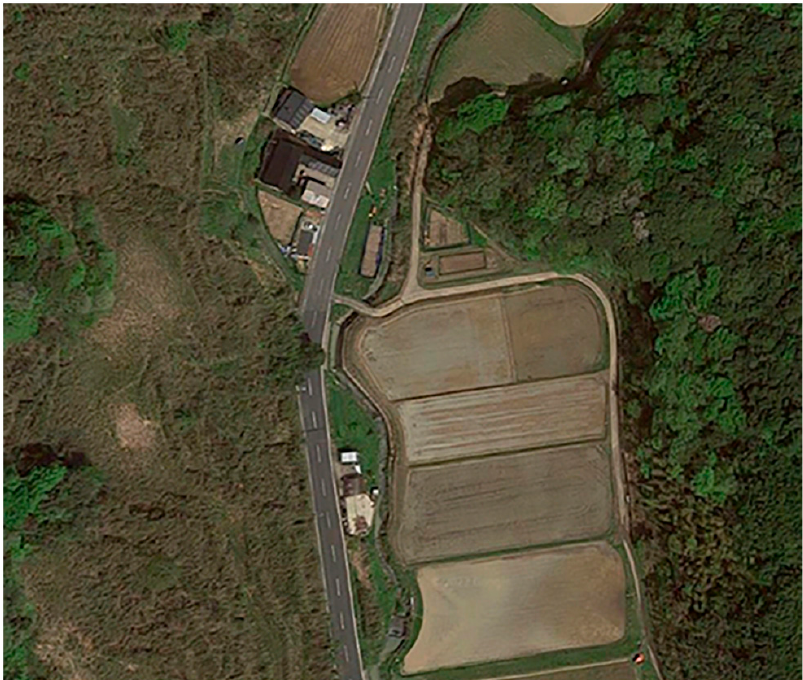
Figure 3. An example of an abandoned farmland mesh area, including buildings and roads (Google map 35.69419° N. and 135.27751° E.).